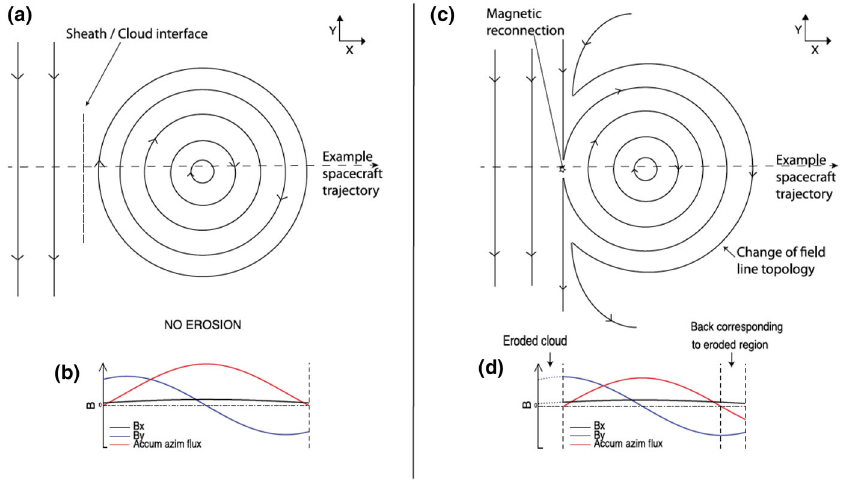
Fig. 30 Illustration of the magnetic configuration of (left) a non-eroded magnetic cloud and (right) an eroded magnetic cloud. The red curve shows the variations of the accumulated azimuthal flux and the blue andblacklinesthevariationsinthefieldcomponents.ThecoordinatesystemistheMCframe(seedefinition, e.g., in Dasso et al. 2005). Image reproduced by permission from Ruffenach et al. (2012), copyright by